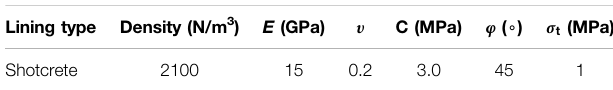
TABLE 1 | Mechanical parameters of the